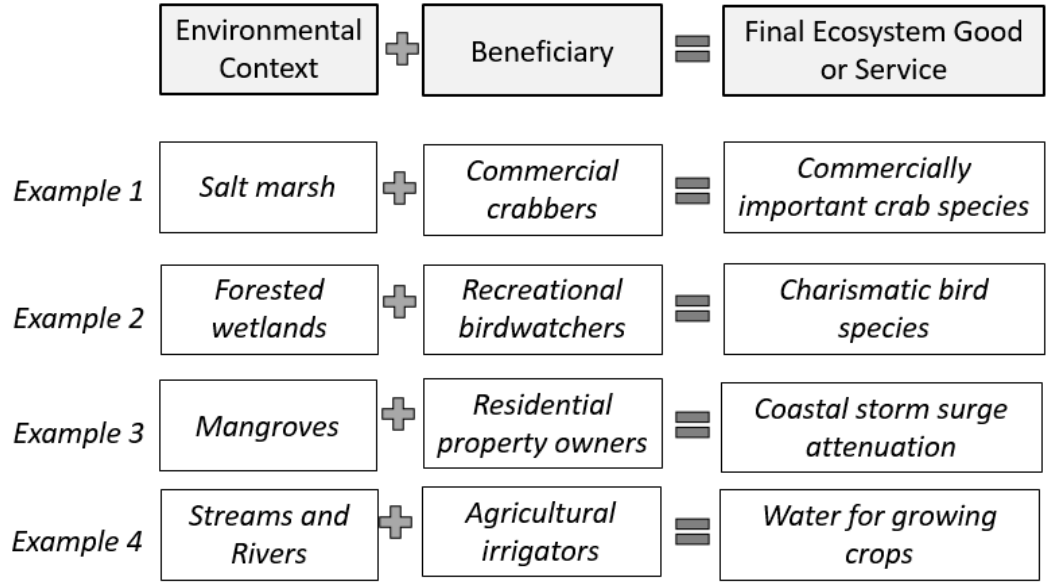
Figure 1. Illustration and examples of the three elements needed to define final ecosystem services.